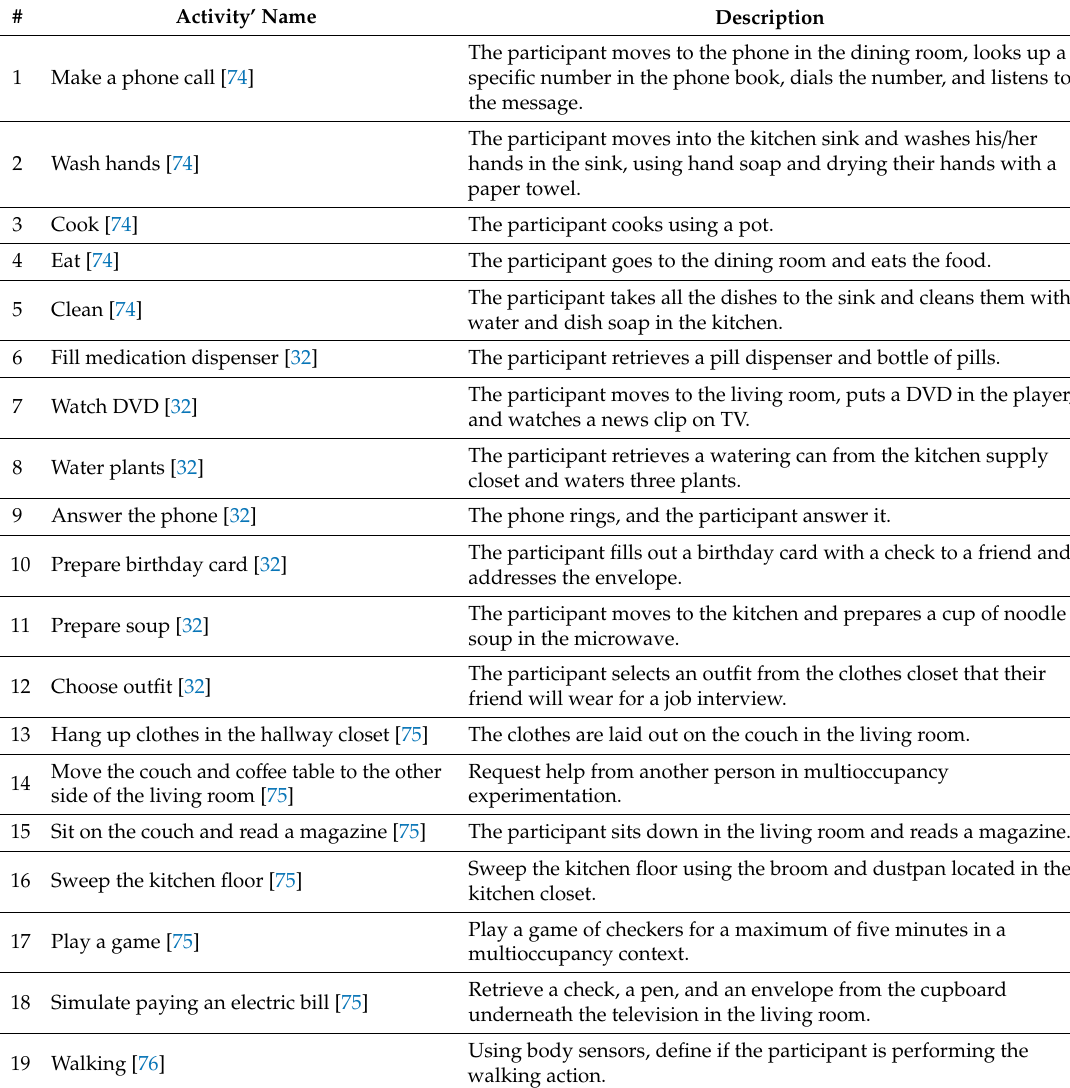
Table 2. Useful activity in Human Activity